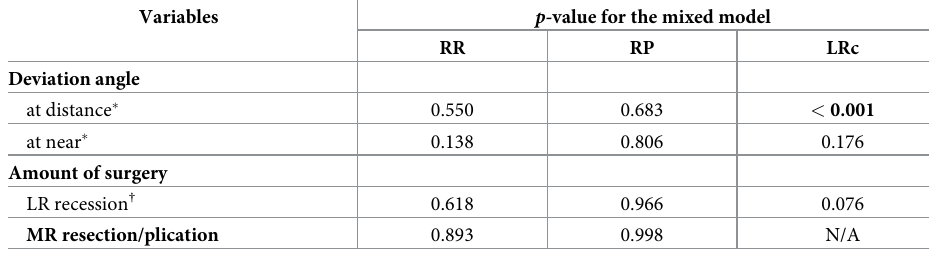
Table 5. Mixed model using interaction terms for the factors associated with postoperative changes in astigma- tism in subgroups according to the type of strabismus.